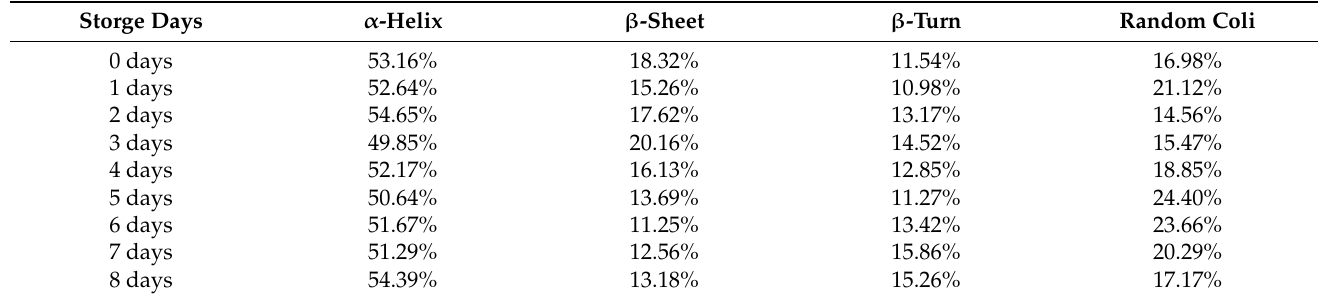
Table 2. Changes in the spatial protein content of rice protein when the relative humidity is 80% and the storage temperature is 30 ◦ C.